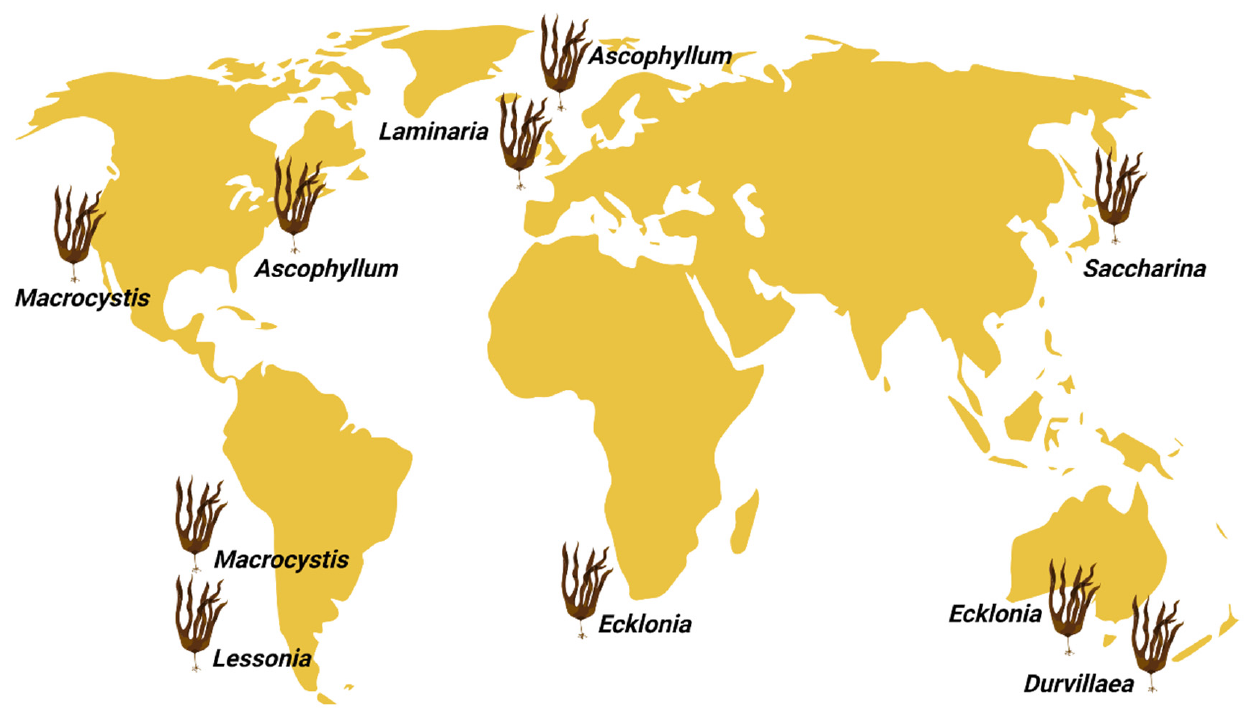
Figure 2. Worldwide geographical areas where some types of algae are used for alginate production. Created with BioRender.